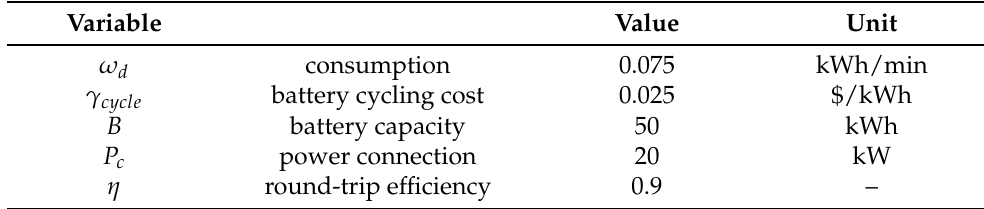
Table 2. Technical